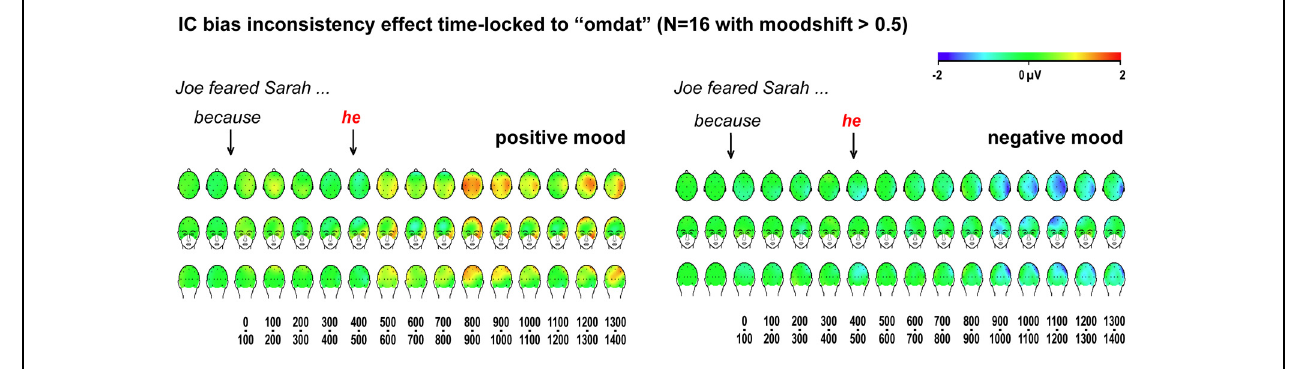
FIGURE 5 | ERP effects for implicit causality items, time-locked to the pre-critical word. Scalp distributions of differential ERP effects to bias-inconsistent (vs. -consistent) pronouns, in 100-ms latency ranges,